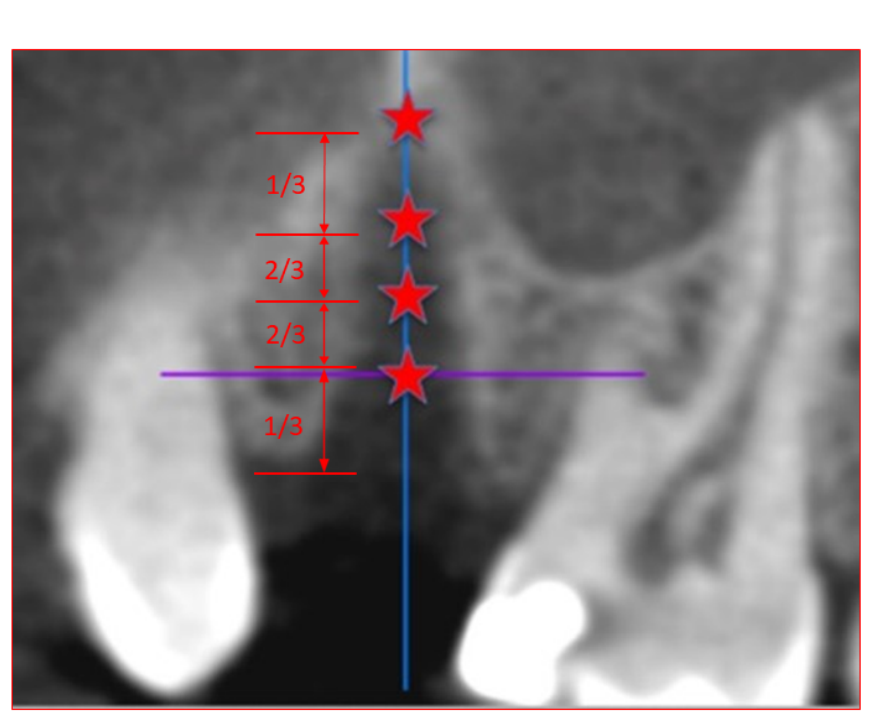
Figure 2. Definition of the measuring points in the cone beam computed tomography scan. The measuring points were located at the junction of coronal third and lower two thirds in the middle and at the junction of apical third and the upper two thirds of the alveoli. Measuring points were arranged on an axis in the center of the alveoli.